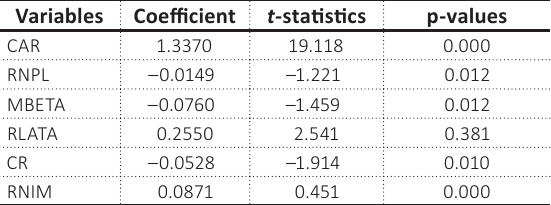
Table 5. Regression results of financial risks